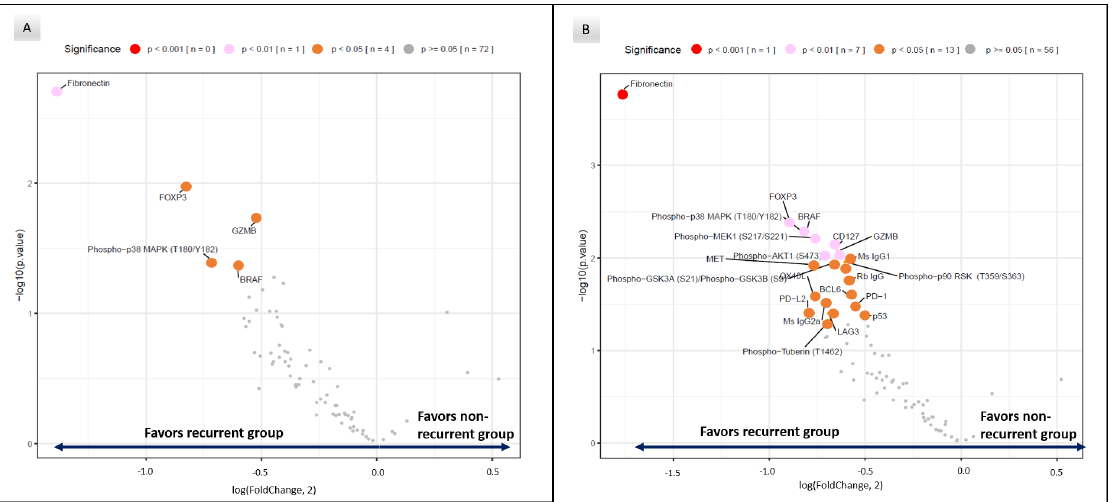
Figure 2. Volcano plots of differentially expressed protein biomarkers for tumor ( A ) and tumor microenvironment ( B ) compartments in recurrent vs. non-recurrent samples. Table 2. Fold-change (log2) differential mean protein expression between recurrent and non-recurrent patients within tumor